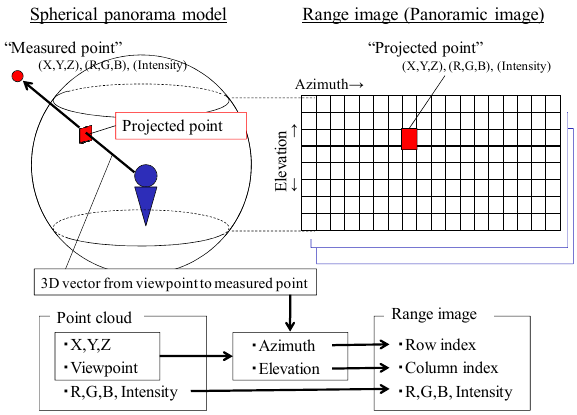
Figure 3. LiDAR VR data comprising a spherical panorama (left side of the figure) and range data (right side of the